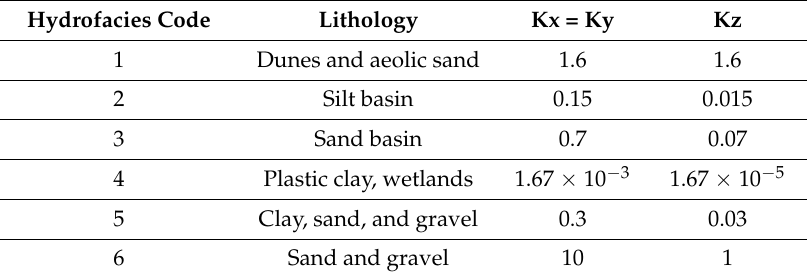
Table 1. Calibrated permeability values for each hydrofacies unit